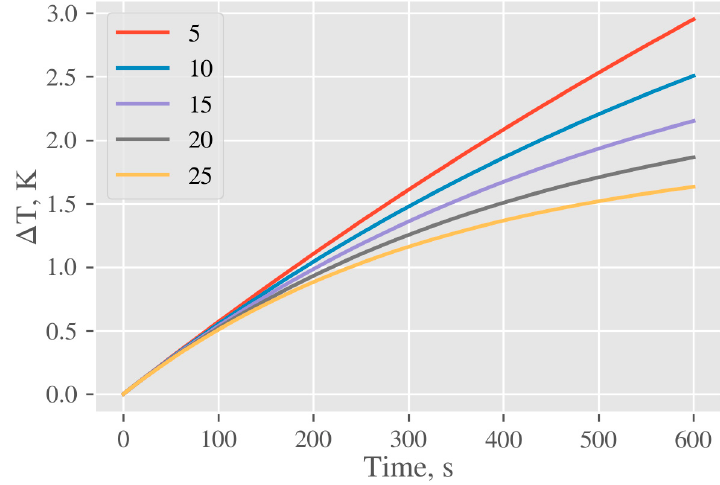
Figure 17. Calculated temperature profiles of AgNPs colloid solution in experimental cuvette due to heat transfer from NPs for typical values of the heat transfer coefficient K conv (5, 10, 15, 20, 25) W m − 2 K − 1 .